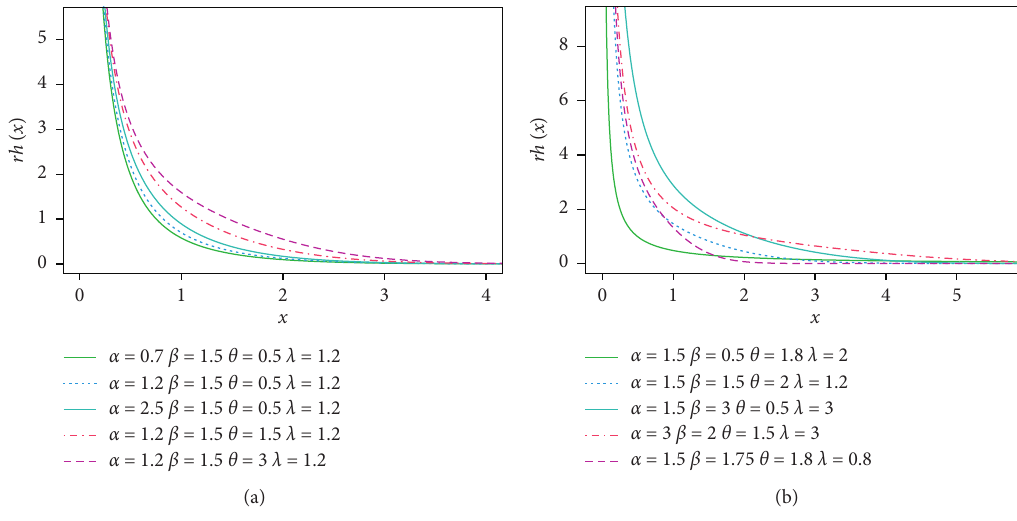
Figure 3: The reversed hazard of MOAPW with different values of the